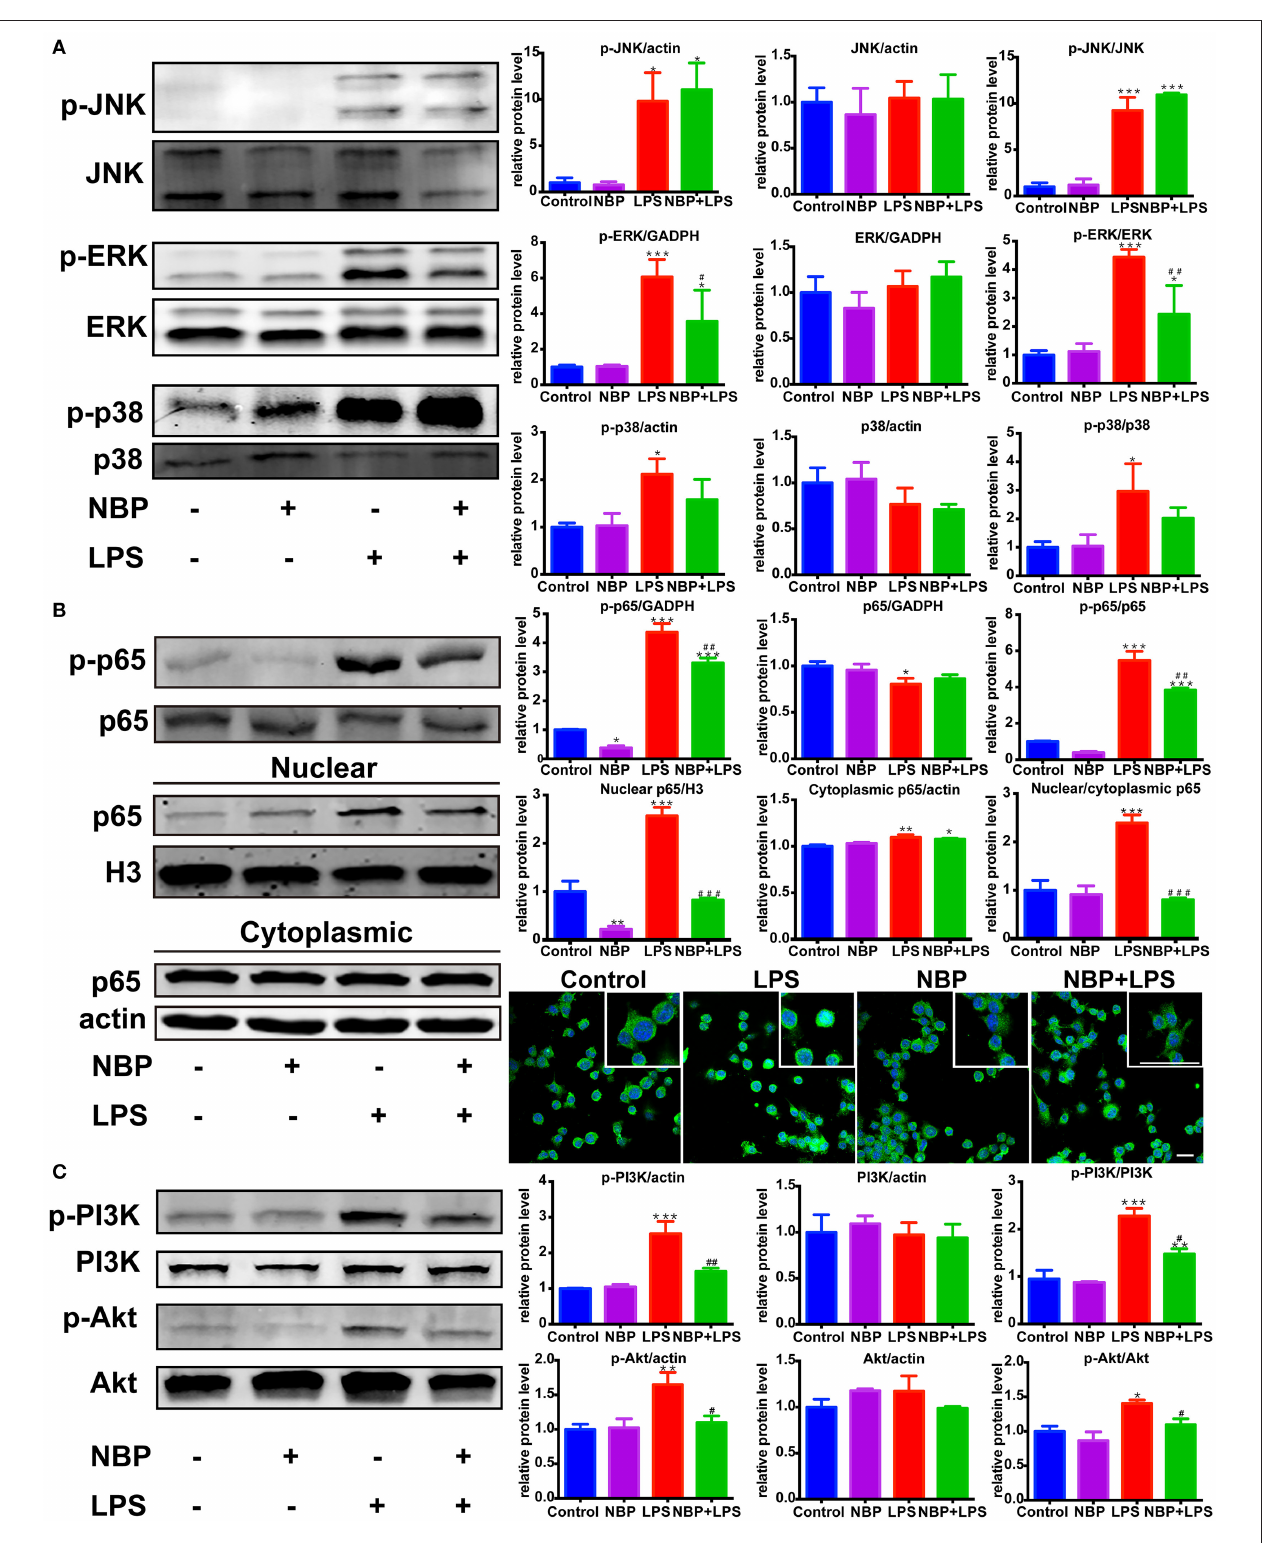
FIGURE 8 | NBP inhibited the activation of ERK, NF- κ B and PI3K/Akt pathways in LPS-stimulated BV-2 cells. (A) Western Blot assay for MAPK expression. The expression of total JNK/p38/ERK as well as p-JNK/p-p38/p-ERK were analyzed. (B) Western Blot assay for NF- κ B expression in whole-cell, nuclear and cytoplasmic extracts. The nuclear translocation of p65 was also evaluated by immunofluorescence detection of p65 (green) and cell nuclei was stained with DAPI (blue) (scale bar: 50 µ m). (C) Western Blot assay for PI3K/Akt expression. The expression of total PI3K/Akt as well as p-PI3K/p-Akt were analyzed. All data are presented as means ± SEM ( n = 3). * p < 0.05, ** p < 0.01, *** p < 0.001, compared with the Control group; # p < 0.05, ## p < 0.01, ### p < 0.001, compared with the LPS group.